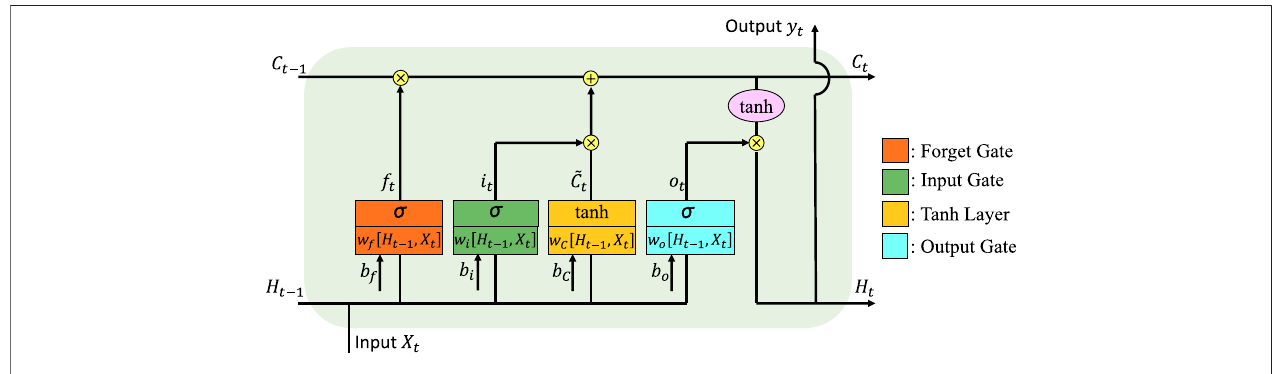
FIGURE 1 | The long short-term memory unit.